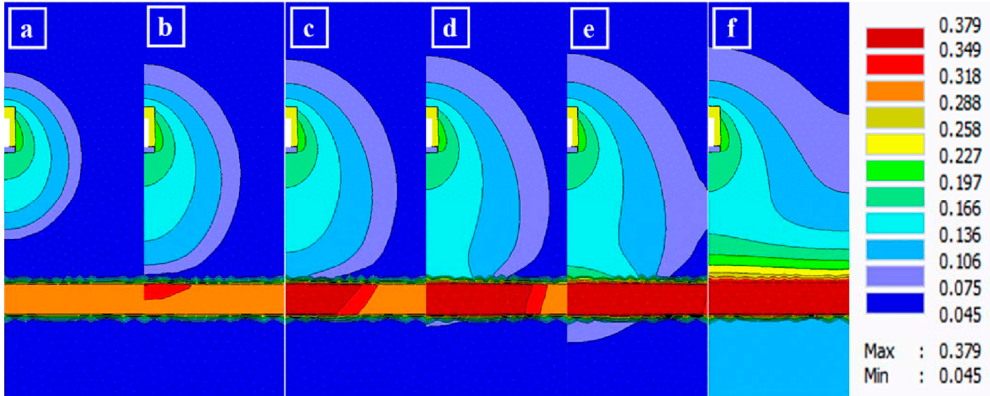
Figure 6. Images showing the change in wetting front at different times in sand above a clay aquifer (( a ) 12 h, ( b ) 24 h, ( c ) 36 h, ( d ) 48 h, ( e ) 60 h, ( f ) 120 h).